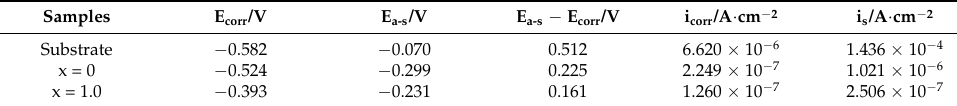
Figure 6. Polarization curves of the samples in the 3.5 wt.% NaCl solution. Table 3. Electrochemical parameters obtained from Figure 6.